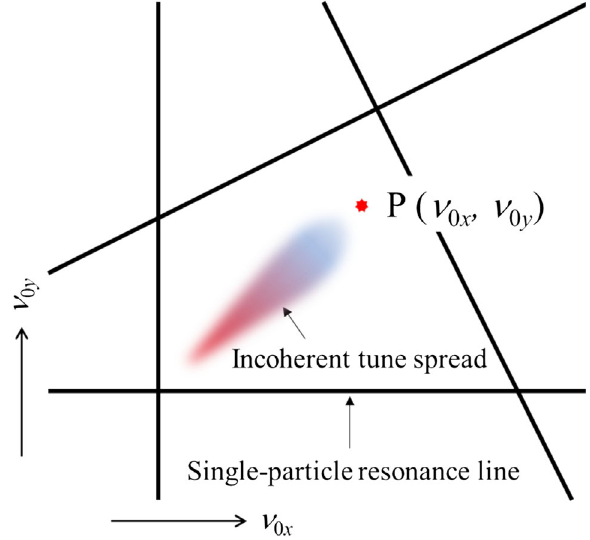
FIG. 1. Determination of a machine operating point on the basis of the conventional incoherent concept. The operating bare tunes ð ν ; ν Þ of a machine are chosen so that the incoherent tune 0 x 0 y spread (shaded area) does not cross low-order single-particle resonance lines. A certain plausible distribution function has to be assumed to estimate the tune-spread area. See Appendix A for an example of the tune spread in the Gaussian